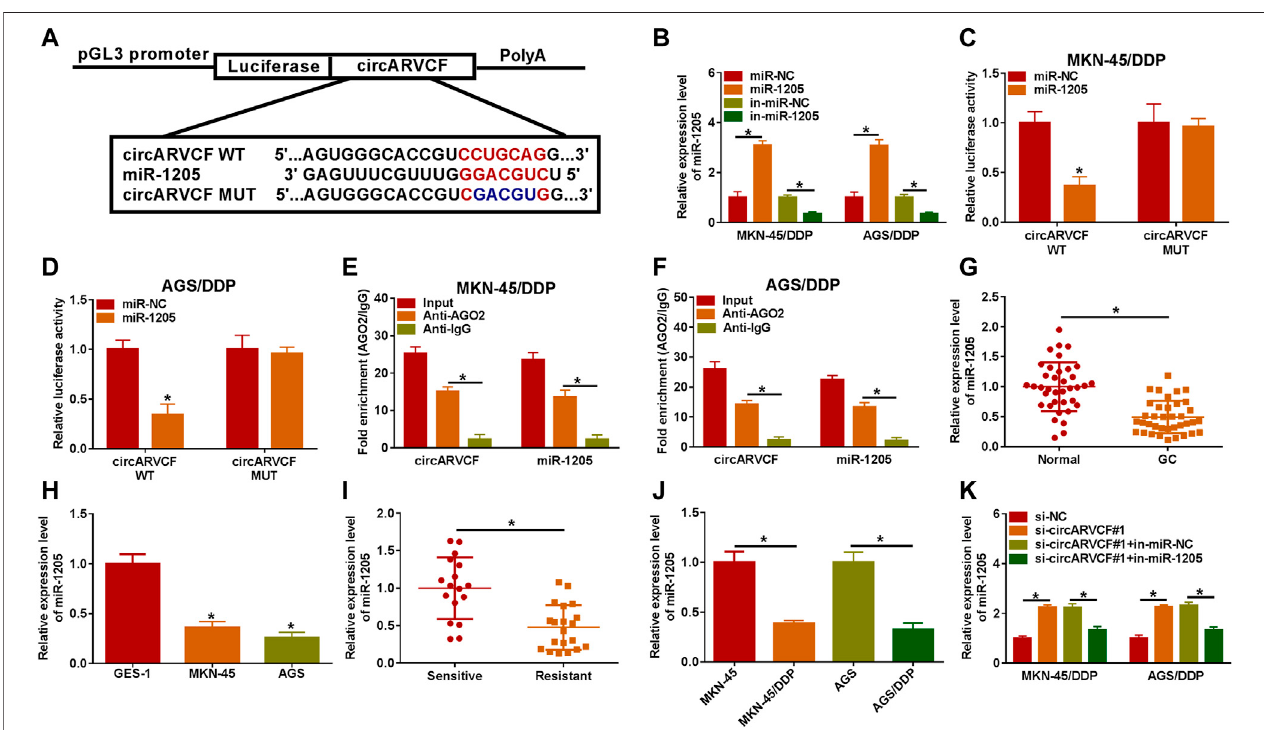
FIGURE 3 | MiR-1205 was the target of circARVCF. (A) The complementary sequences between circARVCF and miR-1205. (B) The expression of miR-1205 in MKN-45/DDP and AGS/DDP cells transfected with miR-NC, miR-1205, in-miR-NC or in-miR-1205 was detected by qRT-PCR. (C – F) The interaction between miR- 1205andcircARVCFwasdemonstratedbydual-luciferasereporterassayandRIPassay. (G,H) TheexpressionofmiR-1205inGCtissues,normaltissues,GCcellsand normalcellswasdetectedbyqRT-PCR. (I,J) Theexpression ofmiR-1205 inDDP-resistantGCtissuesand cellswasexaminedwithqRT-PCR. (K) Theexpression of miR-1205 in MKN-45/DDP and AGS/DDP cells with si-NC, si-circARVCF#1, si-circARVCF#1+in-miR-NC, or si-circARVCF#1+in-miR-1205 was detected by qRT- PCR. * p < 0.05.